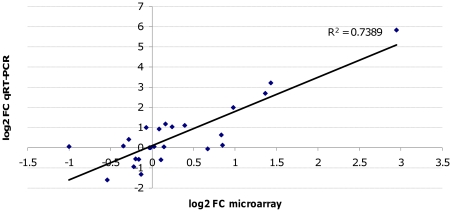
Correlation coefficients of log2 fold changes (FC) by RT-qPCR and microarray analysis.The linear regression is indicated on the plot, with an r2 = 0.7389.